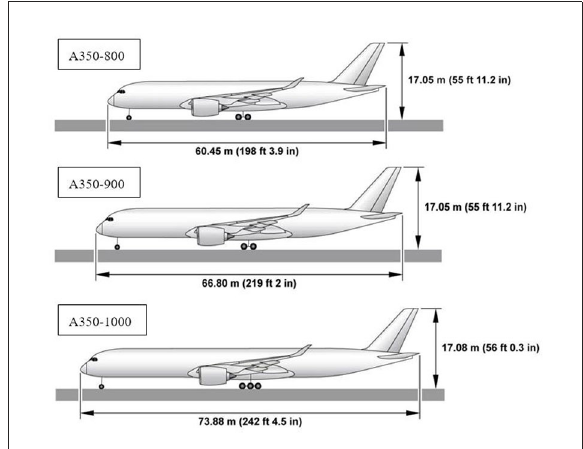
FIGURE1 Airbus A350 series model appearance and size